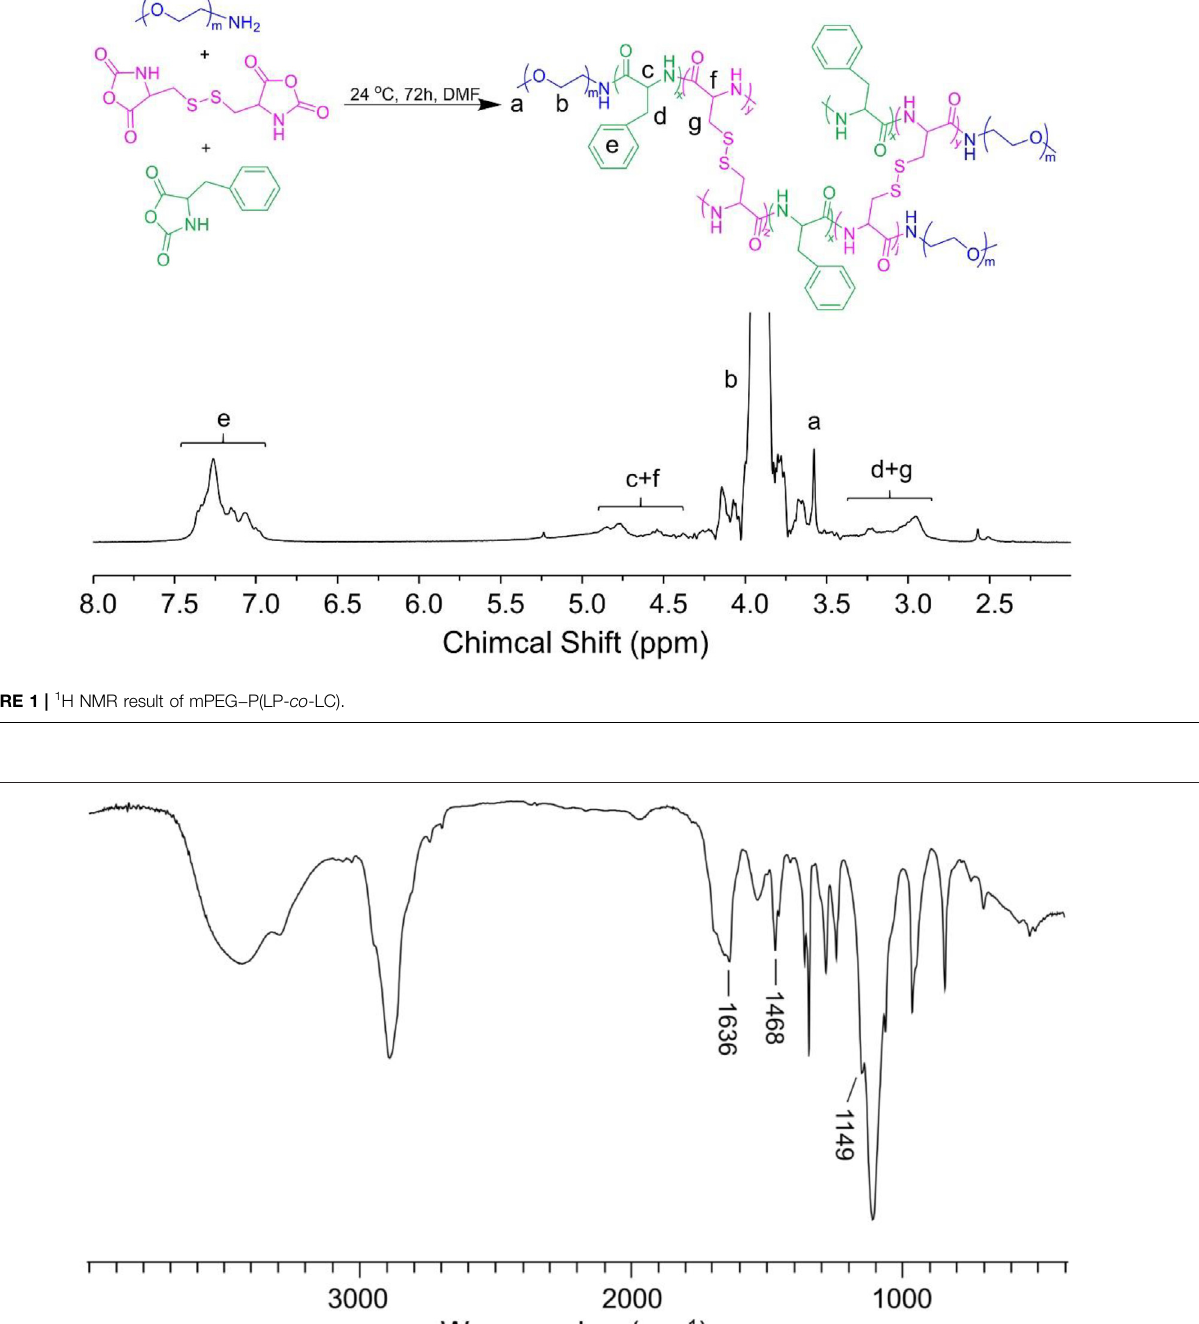
Frontiers in Pharmacology |